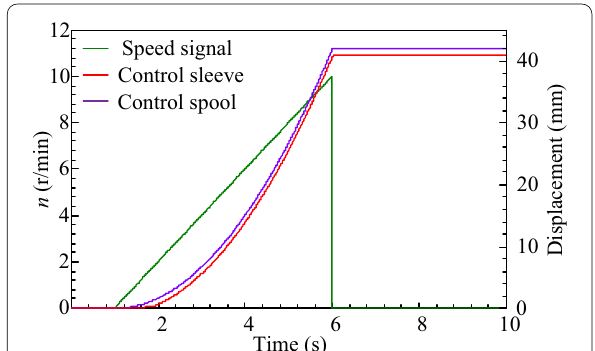
Figure 6 Displacement of control spool and sleeve